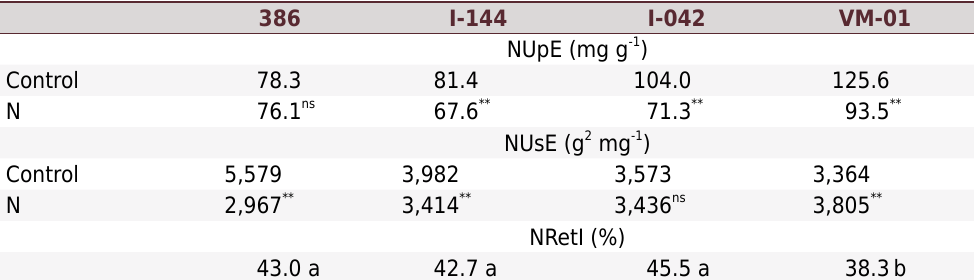
Table 3. Nitrogen uptake efficiency (NUpE), nitrogen use efficiency (NUsE) and translocation index (NRetI) of nitrogen in four Eucalyptus clones (386, I-144, I-042 and VM-01) in response to nitrogen omission and resupply, and control treatments